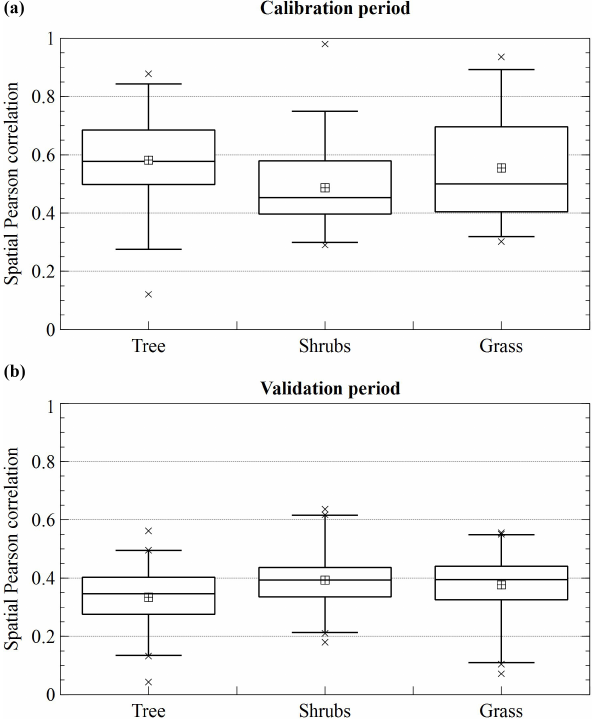
Figure 5. Spatial Pearson correlation coefficient during the calibra- tion (a) and during the validation (b) distinguishing between the main land covers: tree, shrubs and grass. The whiskers were calcu- lated according to the 98th percentile and the outliers were plotted as × symbol. The median is the line inside the boxplot and the mean is the square tile